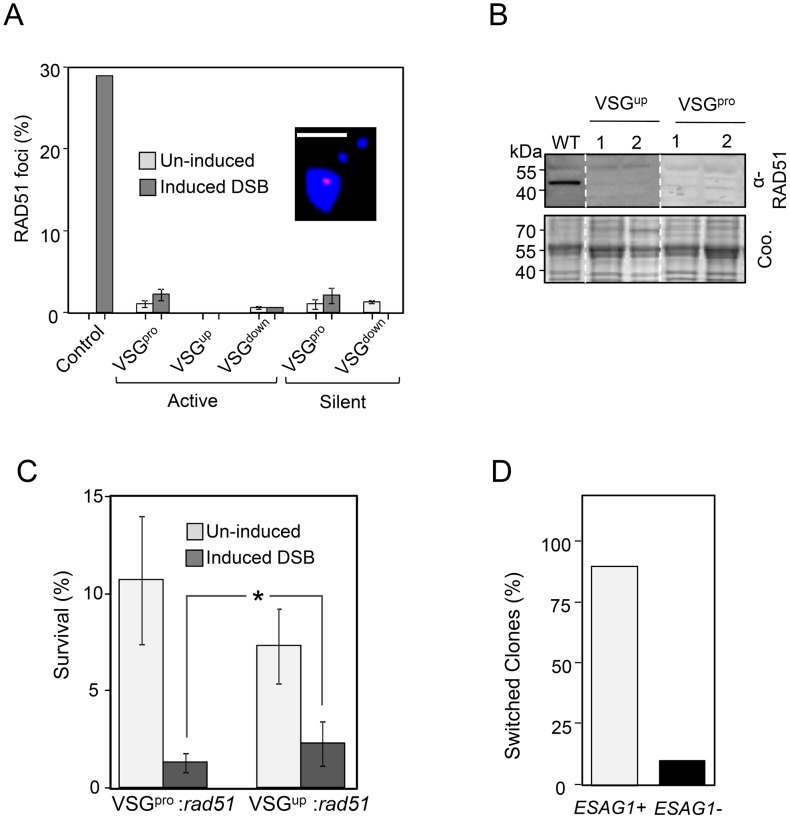
RAD51-dependent and independent BES repair and antigenic variation.(A) Nuclei with RAD51 foci were scored following a DSB at a chromosome-internal locus (Control) or at the active or silent BES. I-SceI expression was induced for 12 h. n = 200 for each bar. Error bars for BES-break strains, SD. The inset shows a representative example of a nuclear RAD51 focus, red; DNA, blue; scale-bar, 5 µm. (B) Western blot analysis of rad51 null strains, the Coomassie panels serve as loading controls. (C) Clonogenic assays. rad51 null strains were distributed in 96-well plates under I-SceI inducing conditions. Survivors were assessed after 7 days. Two independent clones were assayed in triplicate plates for each strain. A wild-type control displayed close to 100% survival (data not shown). Error bars, SD. *, P<0.05 based on Student's t-test. (D). PCR assays were used to check for the presence of the ESAG1 gene in VSGup
rad51-null survivors following I-SceI induction (n = 20).